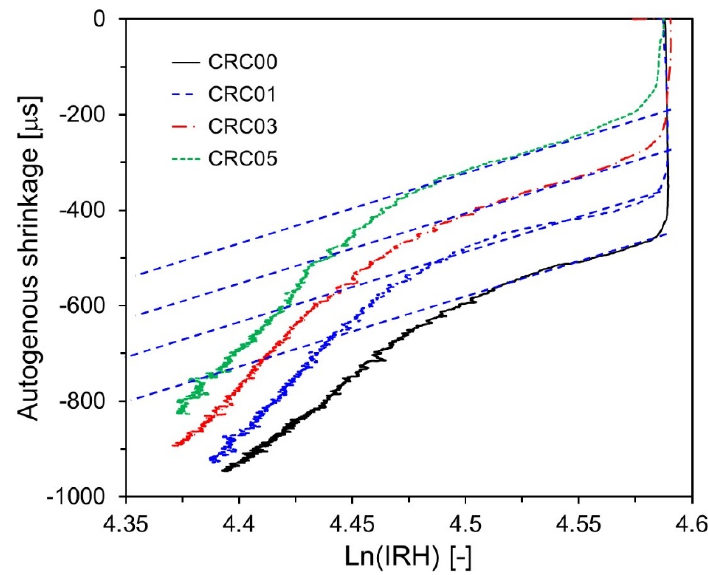
Figure 13. The relationship between autogenous shrinkage and IRH.